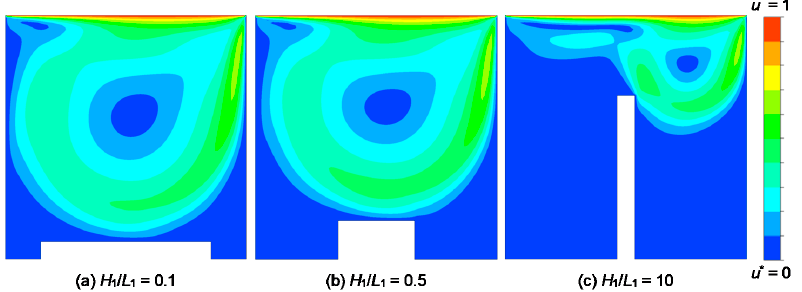
Figure 8. Dimensionless velocity contours for various fin aspect ratios ( H 1 / L 1 ) at Re =1000 and Ra = 10 5 for the fin area fraction of 0.05 and an Al 2 O 3 -volume fraction of 1%. ( a ) H 1 / L 1 = 0.1; ( b ) H 1 / L 1 = 0.5; ( c ) H 1 / L 1 = 10.